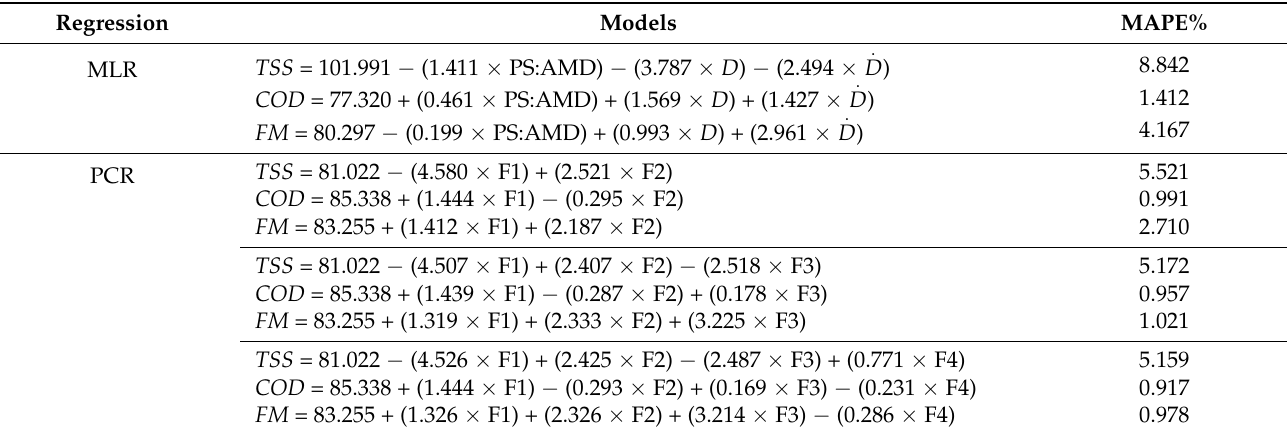
Table 15. Comparison between MLR and PCR models’ accuracy in the prediction of TSS , COD , and FM .